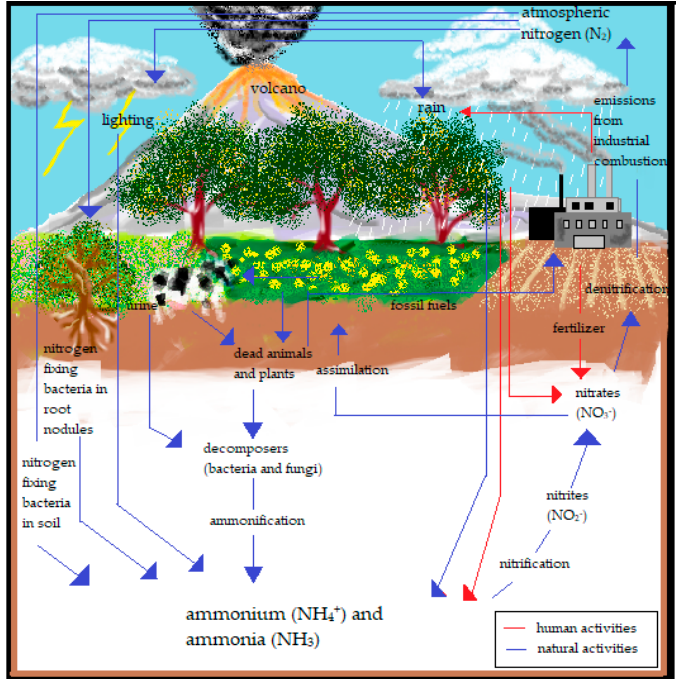
Figure 1. Nitrogen cycle of ammonia through the biosphere.